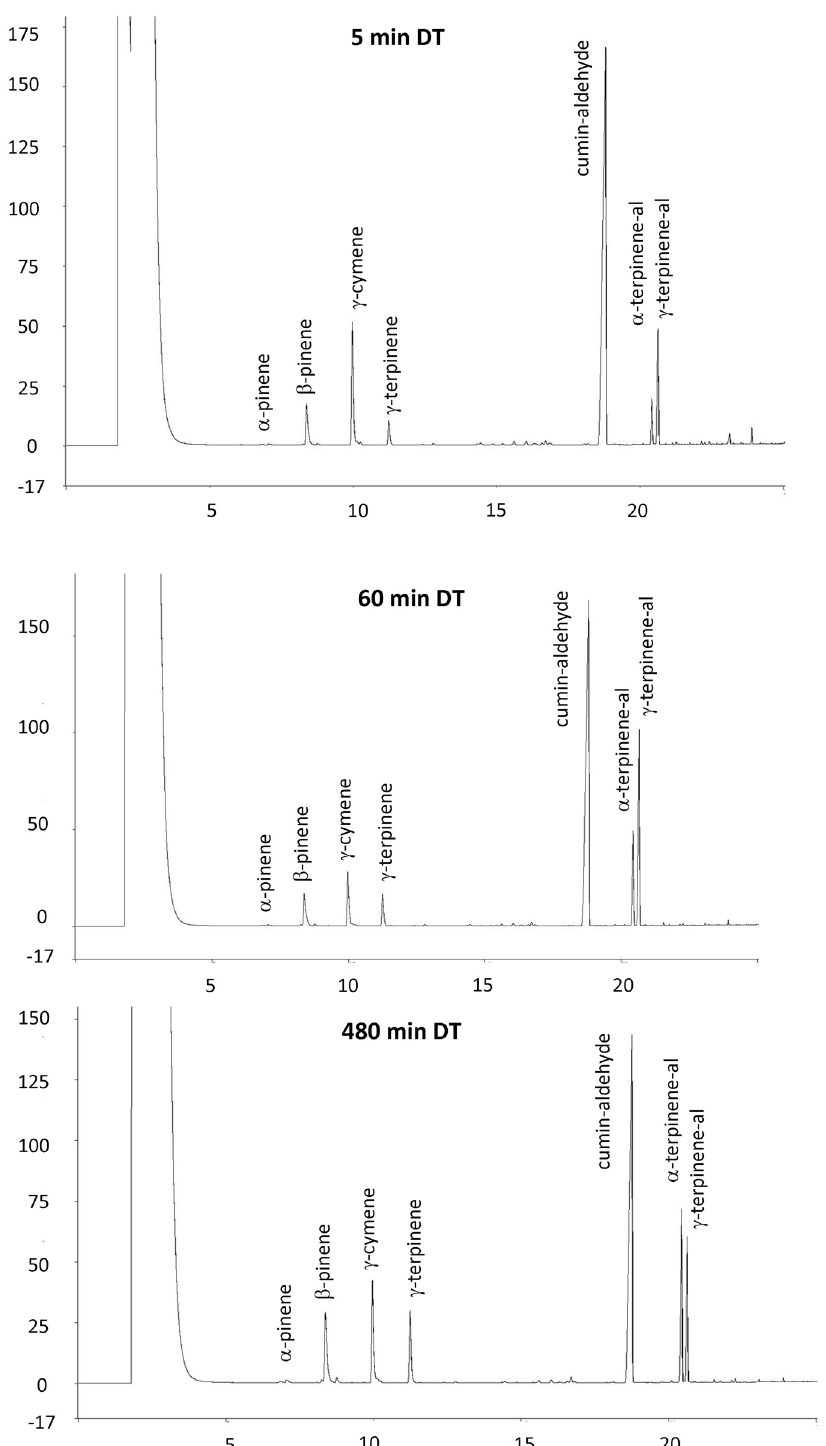
Fig 1. GC-FID Chromatograms of the cumin seed essential oils eluted at 5 min (top) 60 min (middle) and at 480 min DT (bottom).